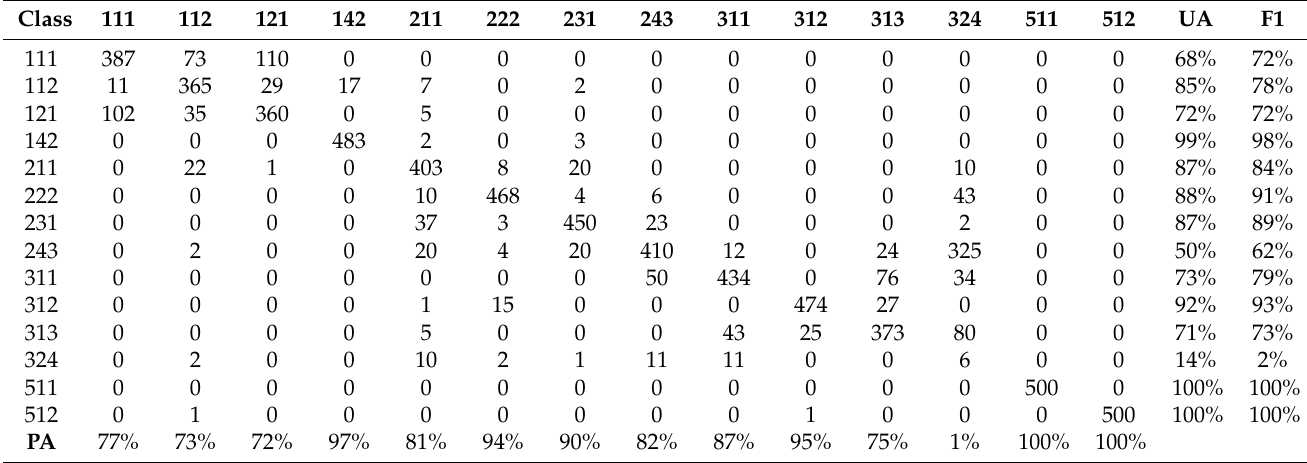
Table 9. Confusion matrix of the East Warsaw area (RF, Sentinel-2 images, OA: 80%, Kappa coefficient 0.78, UA—User Accuracy, PA—Producer Accuracy, F1-score).